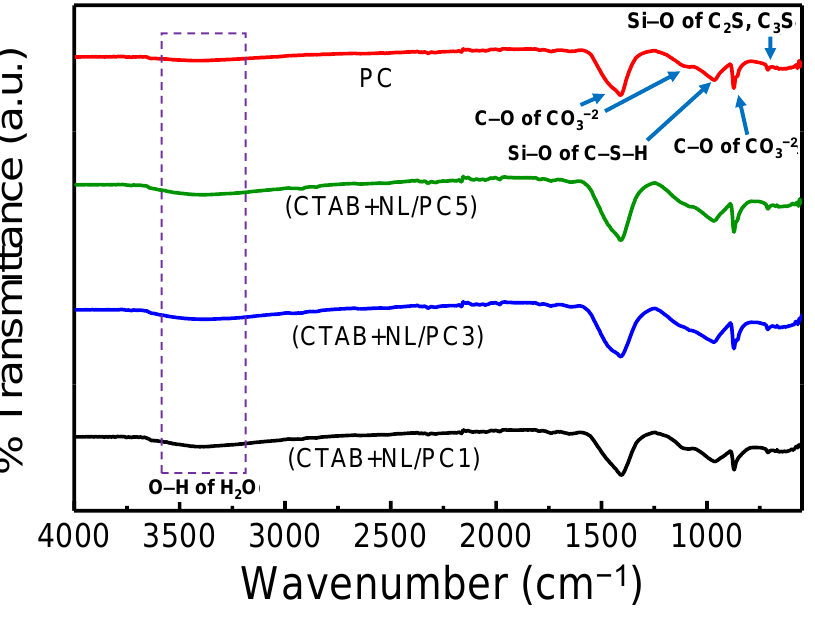
Figure 6. FTIR spectra of the control PC and (CTAB + NL)/PC1, (CTAB + NL)/PC3, and (CTAB + NL)/PC5 composites after 28 d of curing time.